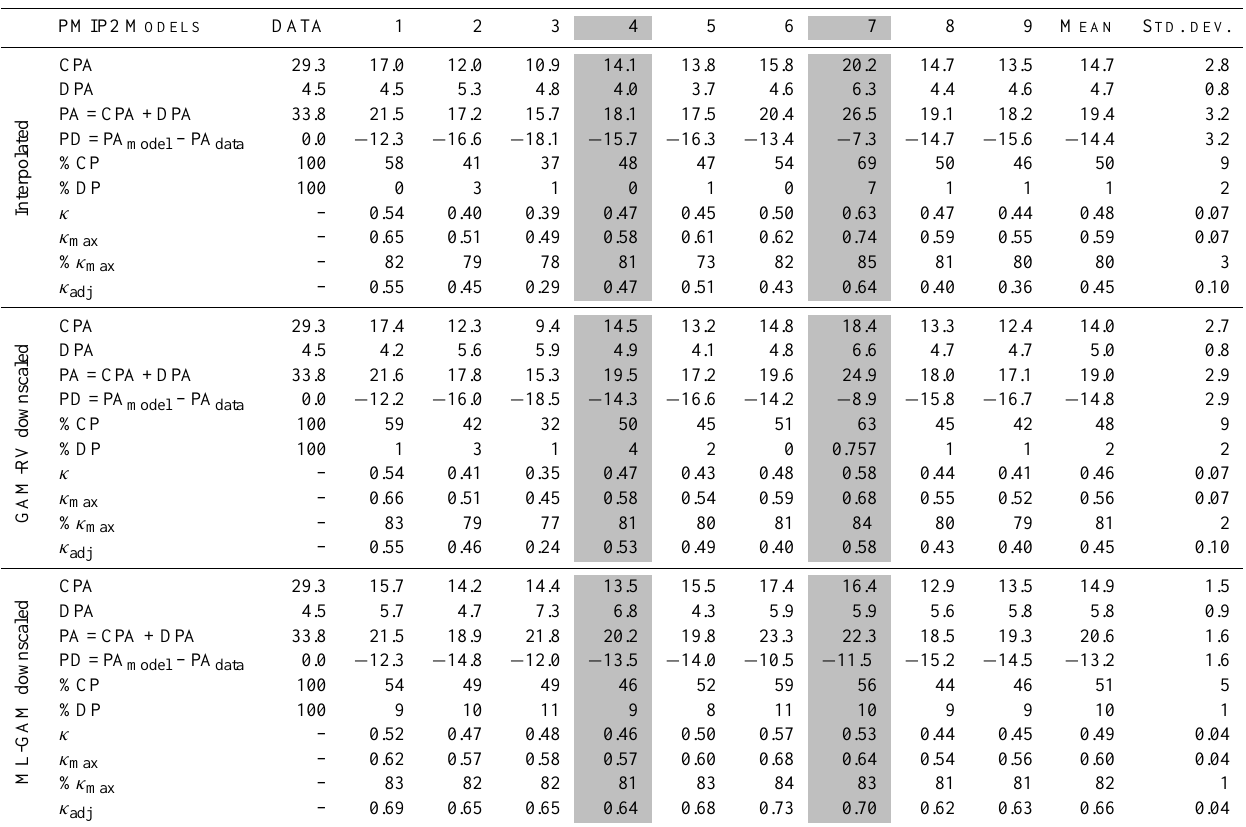
Table 3. PMIP2 quantitative results for LGM period. “DATA” column corresponds to Vandenberghe et al. (2011) data. The CPA, DPA, PA, and PD indices are respectively set for continuous, discontinuous, total permafrost areas and total permafrost difference with data and are expressed in 10 6 km 2 . The %CP and %DP indices are respectively the percentages of continuous and discontinuous permafrost in agreement with data. The κ , κ max , κ adj indices corresponds respectively to the κ coefficient, its maximum value and its adjusted value. The % κ max is the percentage of κ max reached by κ . Numbers from 1 to 9 correspond to the PMIP2 models referenced in Table 1 with ECHAM5 (n ◦ 4) and IPSL-CM4 (n ◦ 7) models shaded in grey. Mean and standard deviation are computed with the nine climate models. For detailed explanation see text